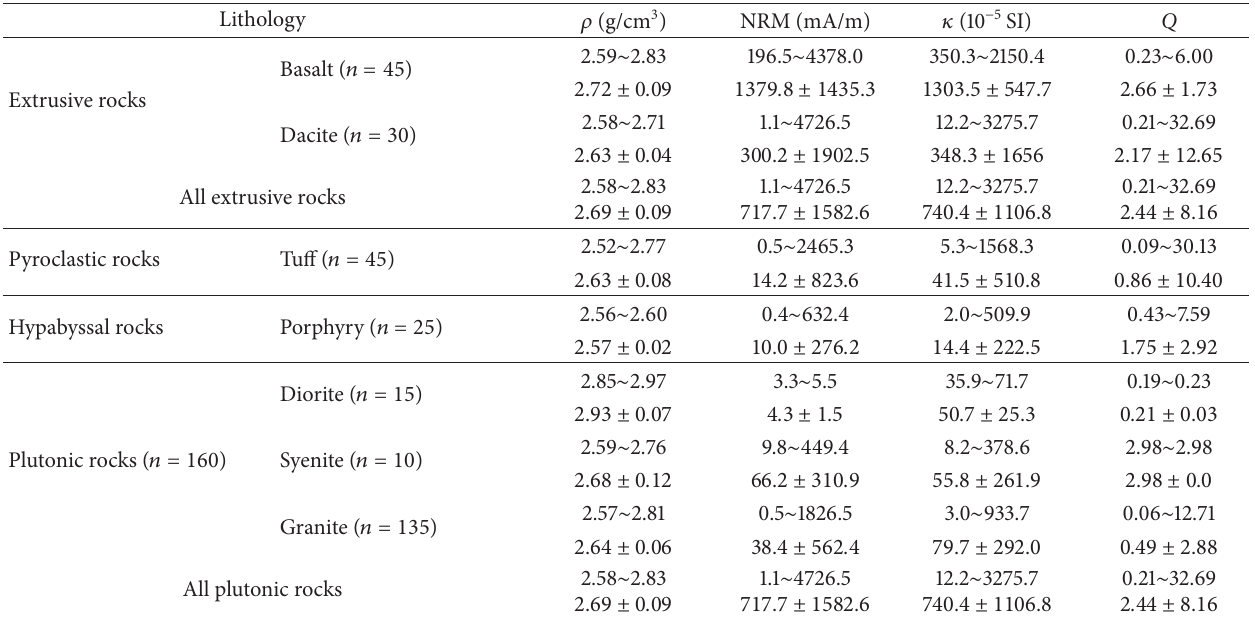
Table 2: Statistical results of 𝜌 , 𝜅 , NRM, and Q values of different igneous rocks.